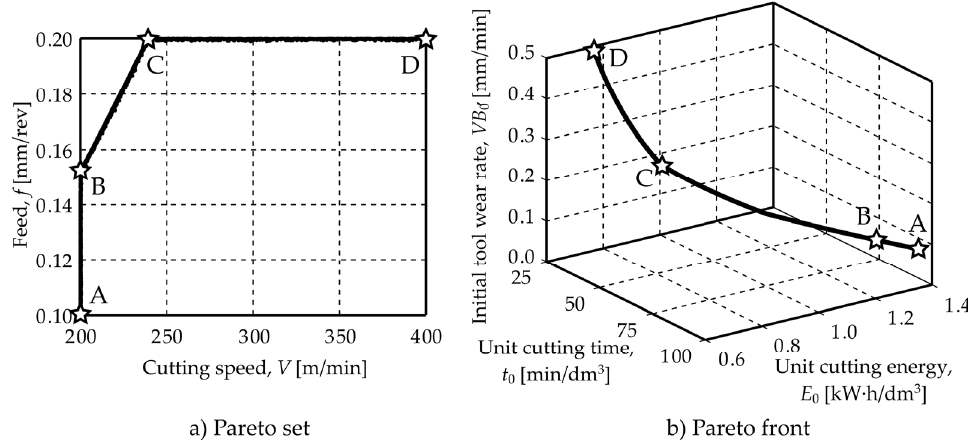
Figure 10. Values obtained in the optimization for machining with MQL. ( a ) graph of the Pareto set, ( b ) graph of the Pareto front (A, B, C and D: most relevant solutions for the selection of machining parameters).